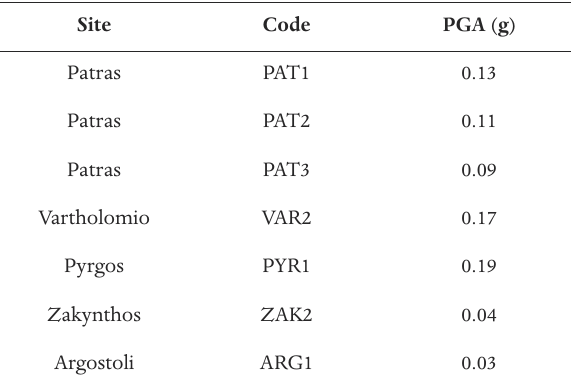
Table 1. Recorded values of the ground acceleration triggered by the earthquake of June 8, 2008 [Margaris et al.